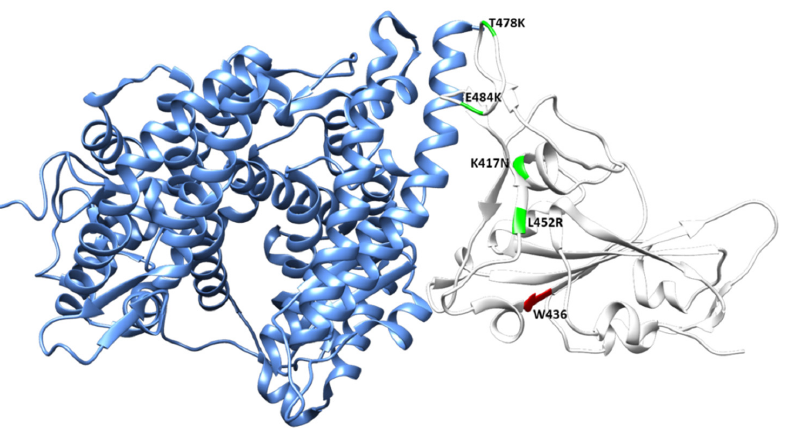
Figure 6. Interaction between the SARS-CoV-2 spike RBD (white) and ACE2 (cornflower blue) as shown by the crystal structure of the RBD/ACE2 complex. The amino acid W436 is labeled in red, whereas the point mutations of the Delta variant (K417N, L452R, E484K, and T478K) are labeled in green.